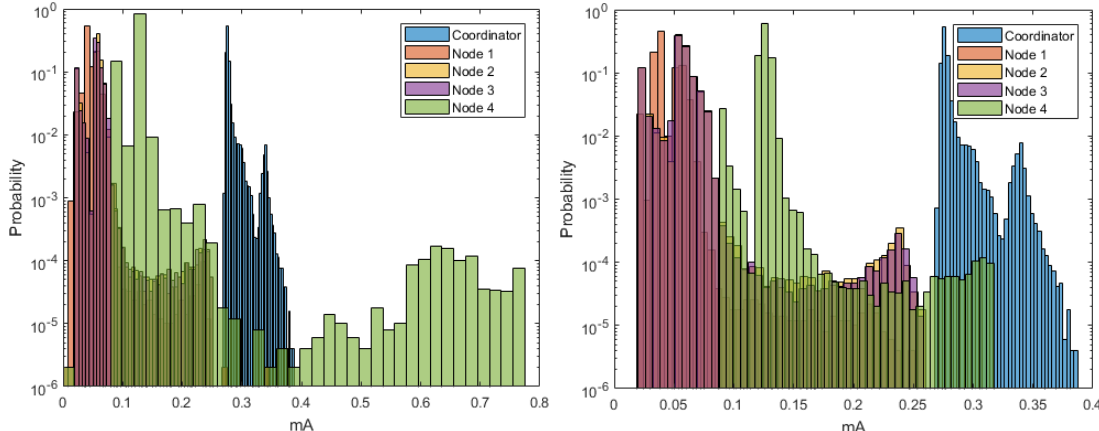
Figure 18. Histograms for WiFi network: ( Left ) at 9600 bauds; and ( Right ) at 57,600